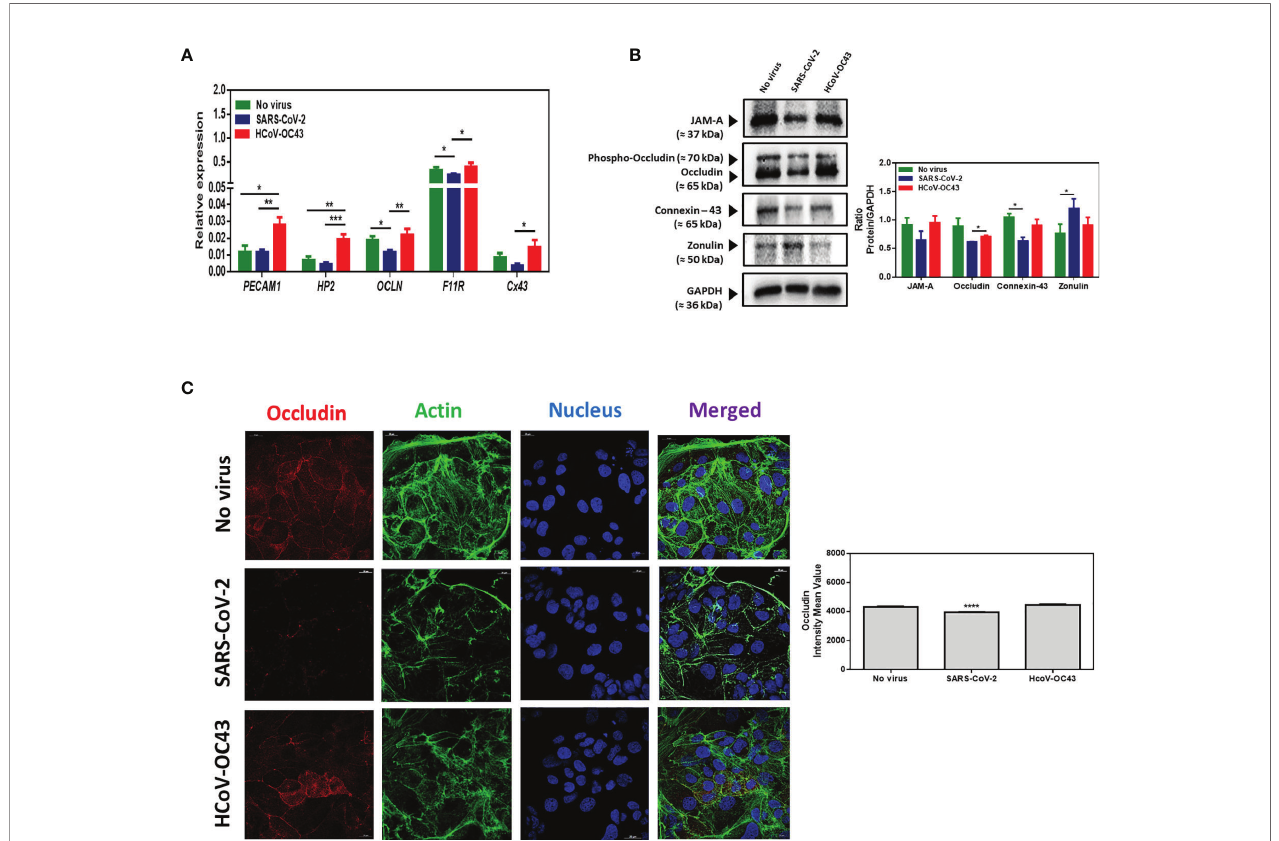
FIGURE 9 | (A) mRNA expression of PECAM1, HP2, OCLN, F11R and Cx43, in virus-free Caco-2 cells or cells exposed to coronaviruses SARS-CoV-2 or HCoV- OC43 at a MOI of 0.5 for 24 hours. The results (n=8) are expressed as RE where RE = 2 ( − D CT) (B) Western blot analysis (left panel) of JAM-A, occludin, connexin-43, and zonulin expression in virus-free Caco-2 cells and cells exposed for 48h to SARS-CoV-2 or HCoV-43 coronaviruses. GAPDH was used as loading control. The quantitative representation (Image J program) of these proteins expression is also illustrated (right panel). (C) Illustration of single plane confocal microscope analysis of occludin expression on subcon fl uent Caco-2 cells grown in RPMI1640 supplemented with 4% FCS only or exposed to coronaviruses SARS-CoV-2 or HCoV-43 at an MOI of 0.5 for 24 hours (left panel). The analysis was performed on unpermeabilized cells. Actin expression was shown as control as well as the labeling of the nucleus. A quantitative representation of mean fl uorescence intensity corresponding to occludin protein expression on Caco-2 cells infected or not with SARS-CoV-2 or HCoV- OC43 is shown (right panel). The symbol * means a p-value < 0.05; ** means a p-value < 0.01; *** means a p-value < 0.001; **** means a p-value <